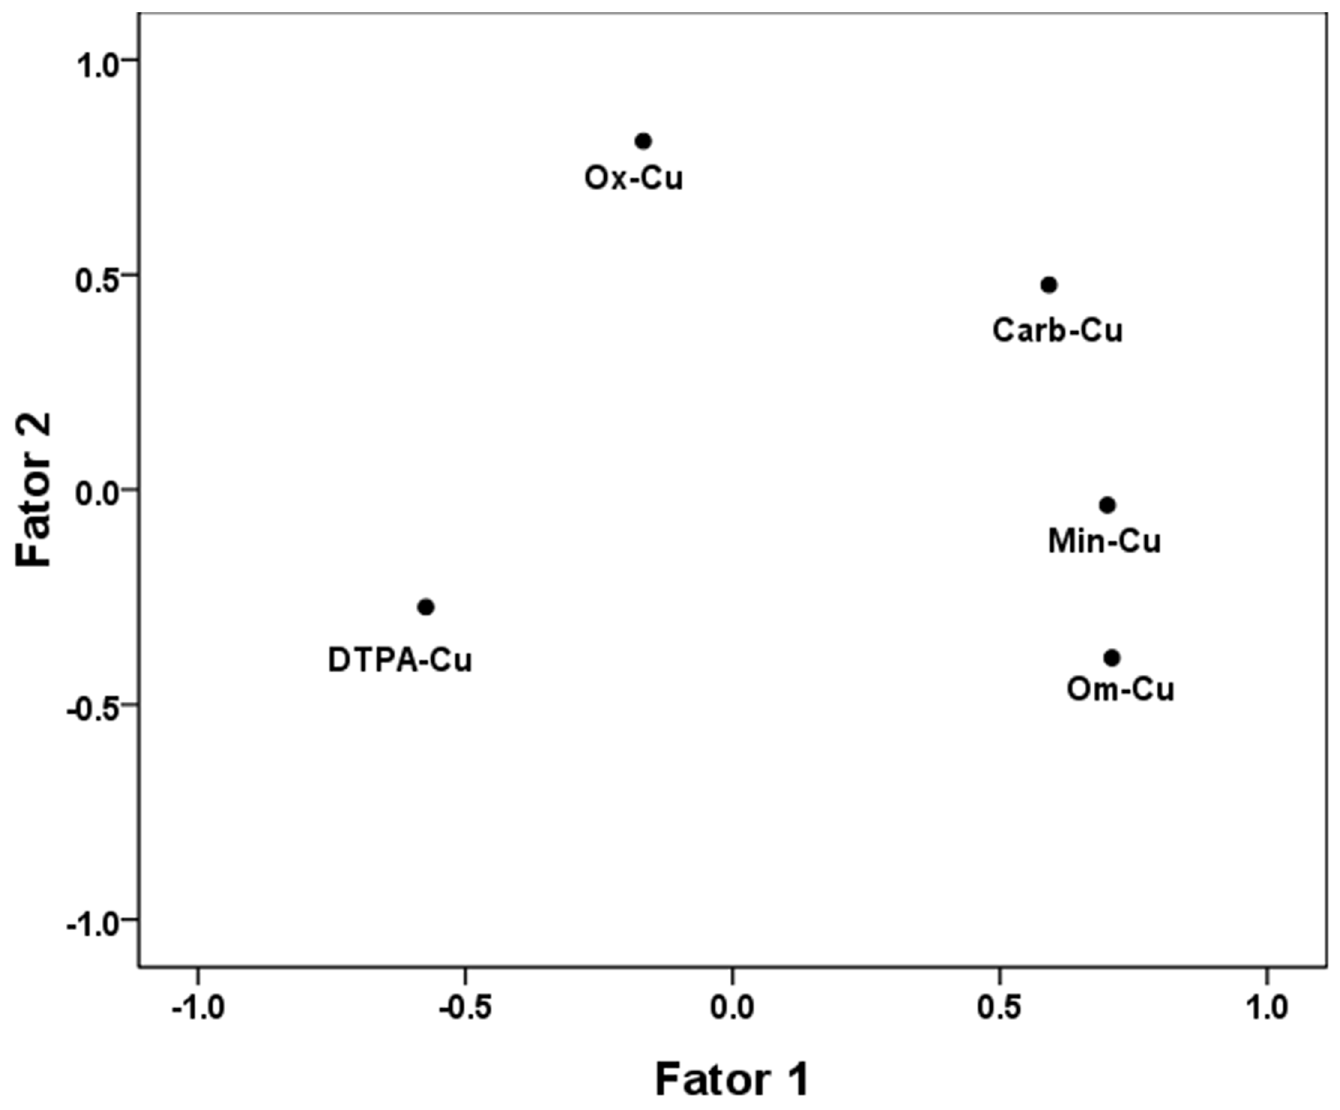
Fig 4. Factor plot of DTPA-Cu and Cu fractions. Carb-Cu, carbonate-bound Cu; Ox-Cu, oxide-bound Cu; Om-Cu, organic-matter-bound Cu; and Min-Cu, mineral-bound Cu.